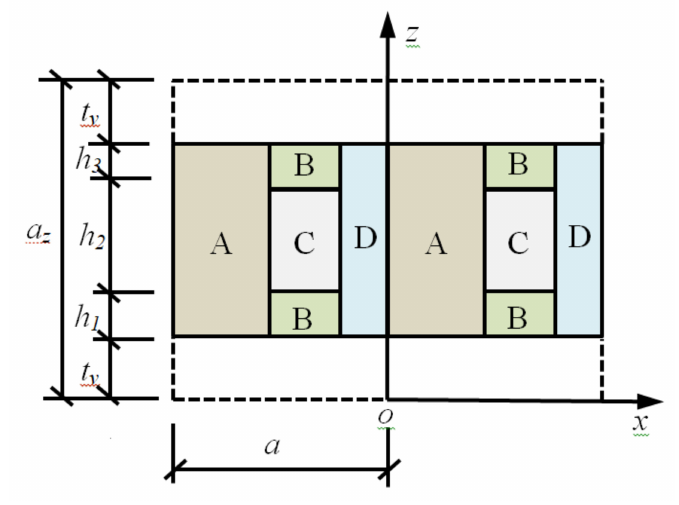
Figure 2. Supercell